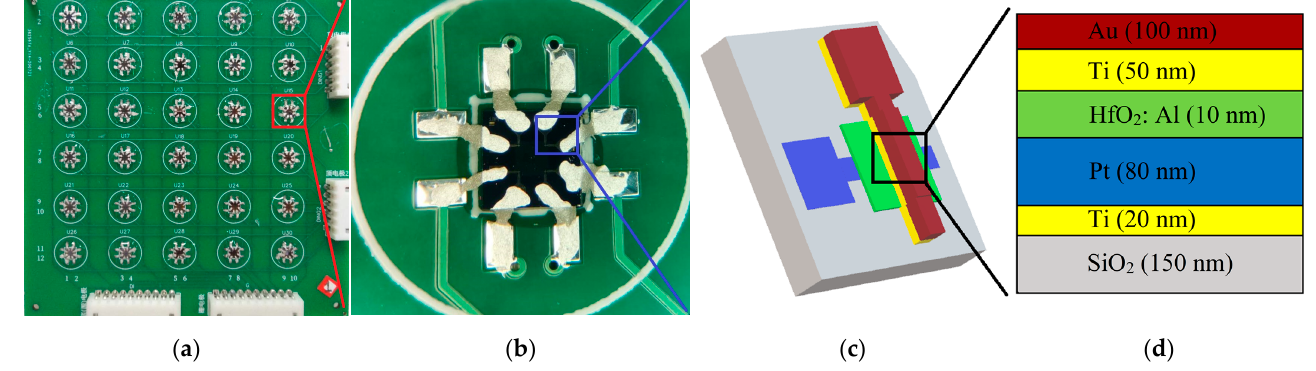
Figure 1. ( a ) The physical diagram of the 1T1R array of 12 rows × 10 columns on a 10 cm × 10 cm PCB. The top electrode of the memristor is connected to the bit line (BL), the bottom electrode is connected to the drain of the NMOS, the source is connected to the source line (SL), and the gate is connected to the word line (WL). ( b ) The micrograph of conductive silver glue lead. ( c ) The three-dimensional schematic diagram of Ti/HfO 2 : Al/Pt RRAM device structure. ( d ) The schematic diagram of RRAM device structure, the thickness of each layer does not represent the true proportion.